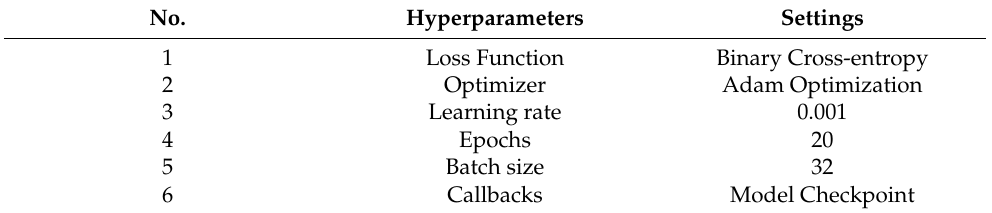
Table 2. Hyper-parameters settings for training. No. Hyperparameters Settings 1 Loss Function Binary Cross-entropy 2 Optimizer Adam Optimization 3 Learning rate 0.001 Epochs Batch size Callbacks Model